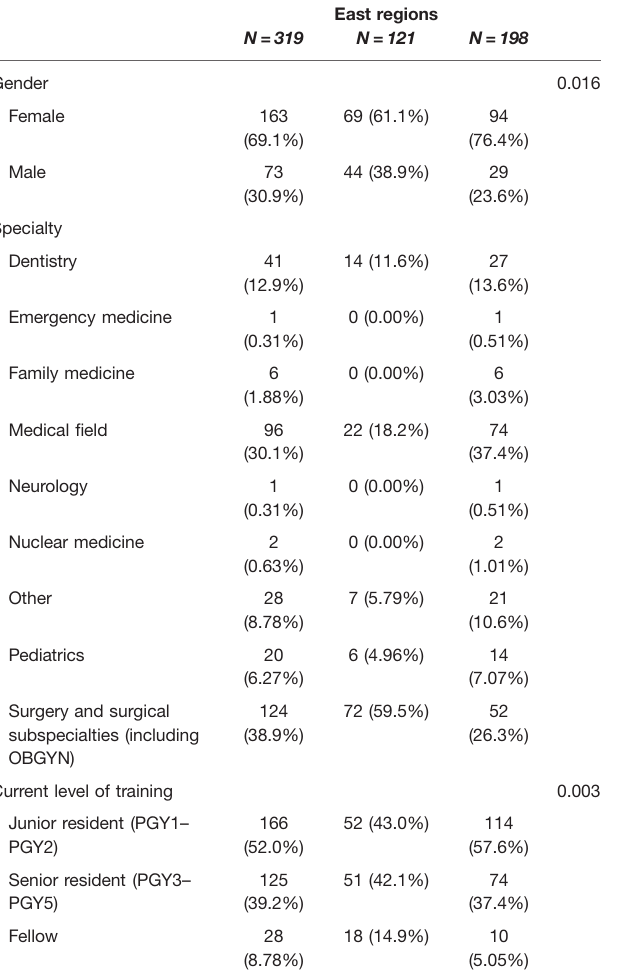
TABLE 1A | Descriptive statistics for the study sample strati fi ed by residency location.